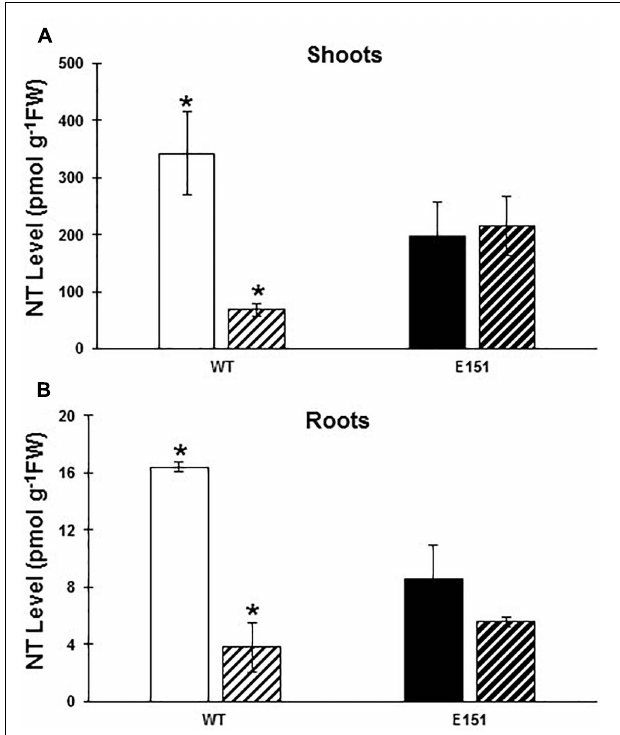
FIGURE 4 | Levels [pmol g − 1 of fresh weight (FW)] of nucleotides (NT; trans ZNT, cis ZNT, and iPNT) in the shoots (A) and the roots (B) of WT (white bars) and E151 (black bars) plants. Plants inoculated with R. irregularis (bars with hatched lines) or non-inoculated (solid bars) were harvested 13 days after planting. Data (mean ± SE; n = 3) were subjected to a Student’s t -test to determine significant differences between myc − and myc + plants. An asterisk indicates significance at a 95% confidence